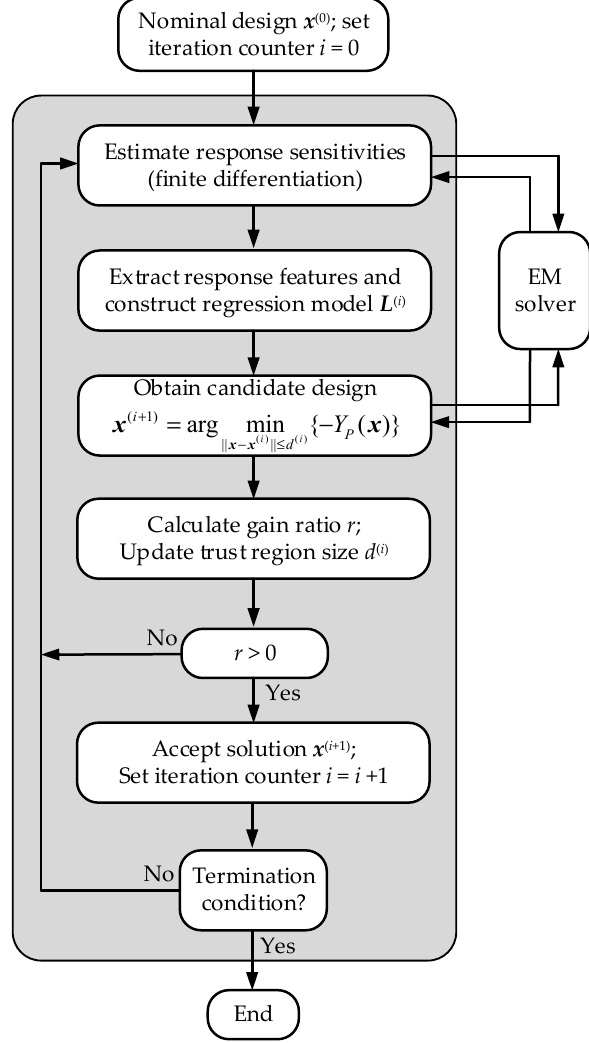
Figure 2. Operating flow of the proposed design centering algorithm.